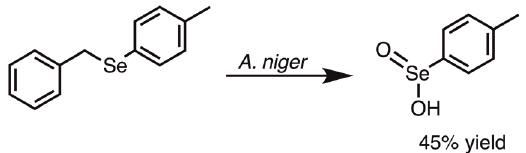
Figure 41 - Oxidation of benzyl(p-tolyl)selane with A. niger .